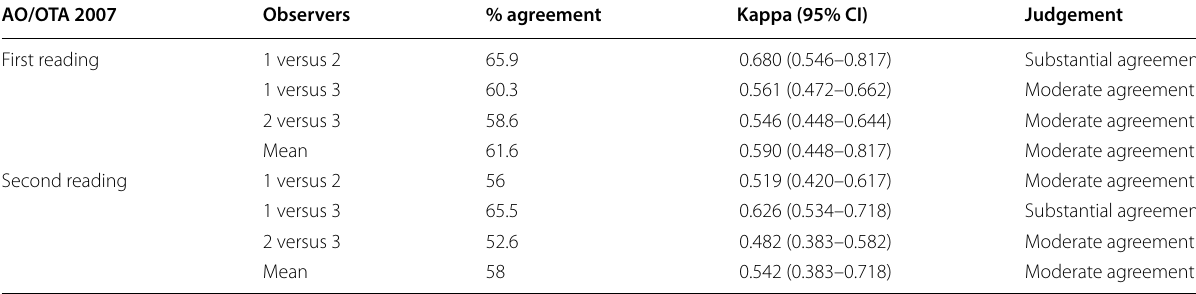
Table 2 Level of agreement among observers for the AO/OTA 2007 classification after both review sessions